Question: What direction does the quantity move in — increasing or decreasing?
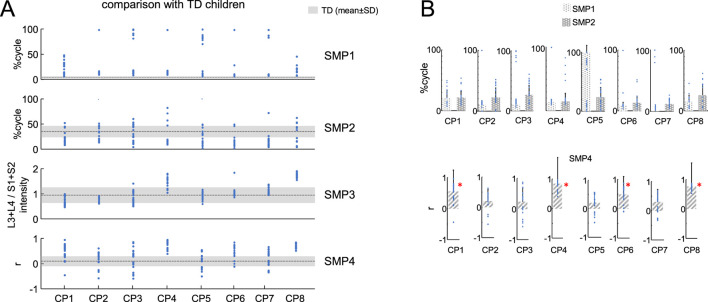
Answer: increasing